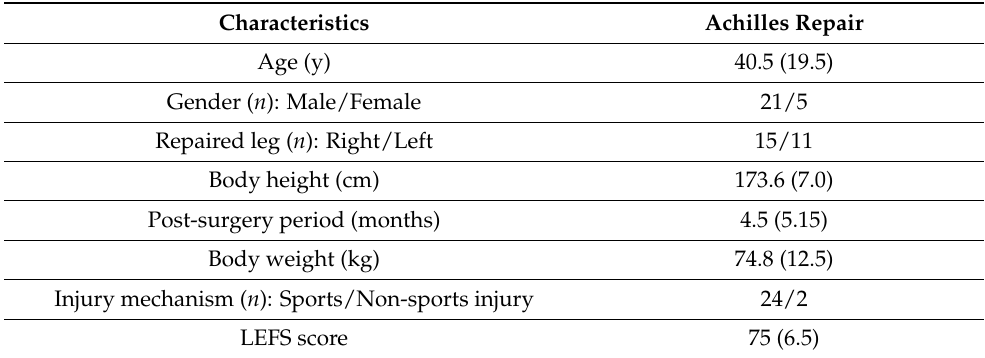
Table 1. Characteristics [reported as means (interquartile range)] and self-reported functional levels of the participants with an Achilles rupture ( n =